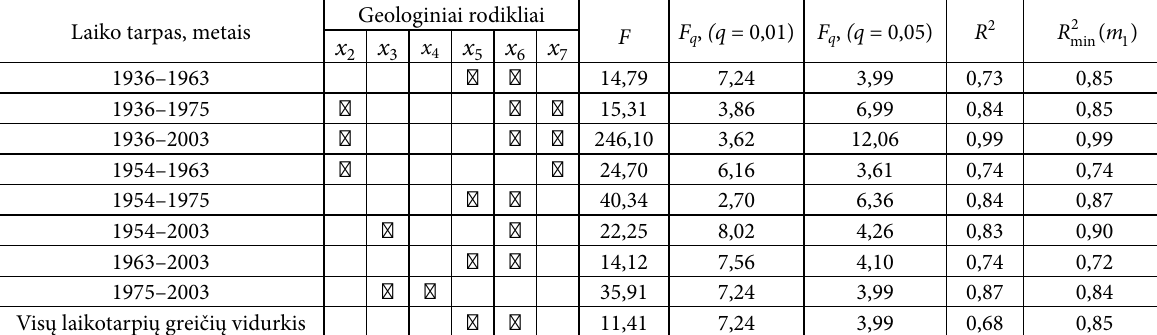
Table 4. Results of incremental regressive analysis Laiko tarpas,